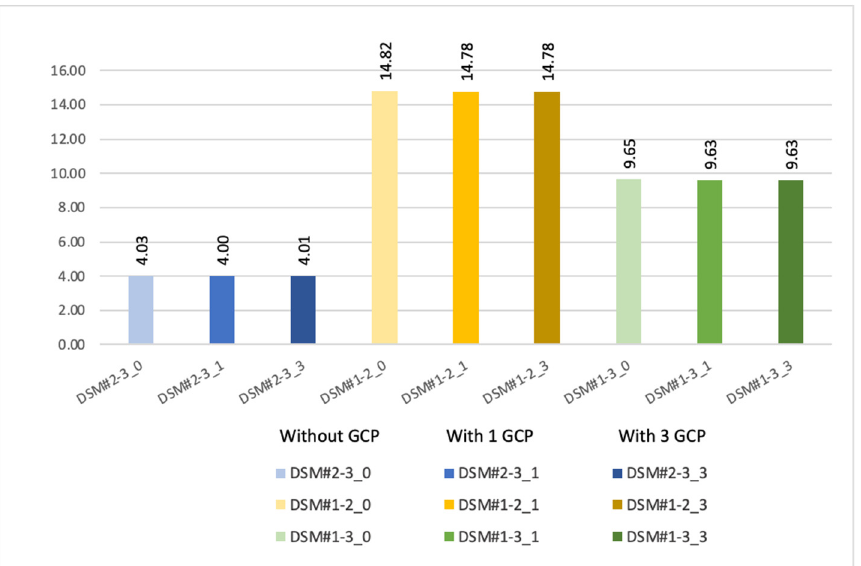
Figure 6. Bar plot of the root mean square error from Pleiades–1 DSM computed by pairs without, with 1, or with 3 ground control points.